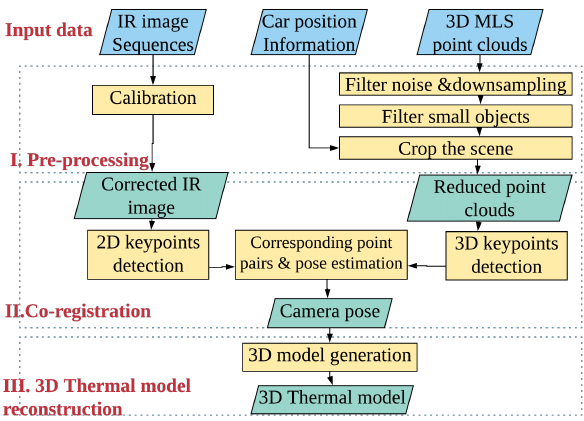
Figure 1. Figure placement and